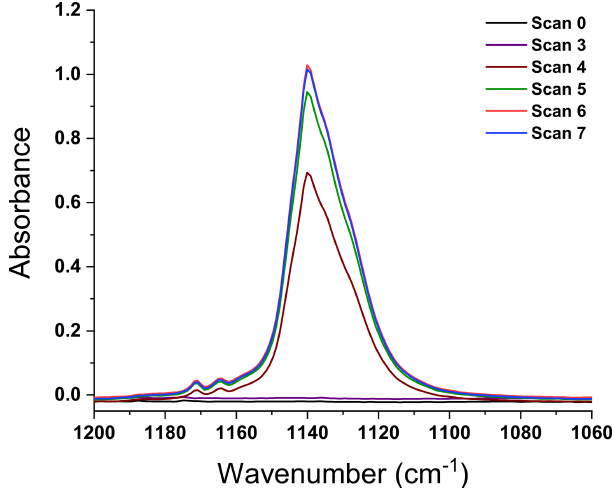
Figure 2. Dynamic spectra recording the introduction of CFC-11 from the extractive probe to the gas cell. Scan 0 represents the start of spectral acquisition and freon release near the probe. Spectra were produced every 0.79s. The first freon observation occurs with scan 4; maximal absorbance of CFC-11 and stabilization occur at scan